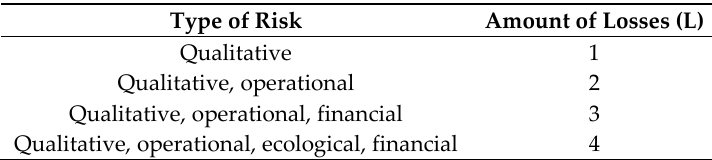
Table 2. Losses (L).